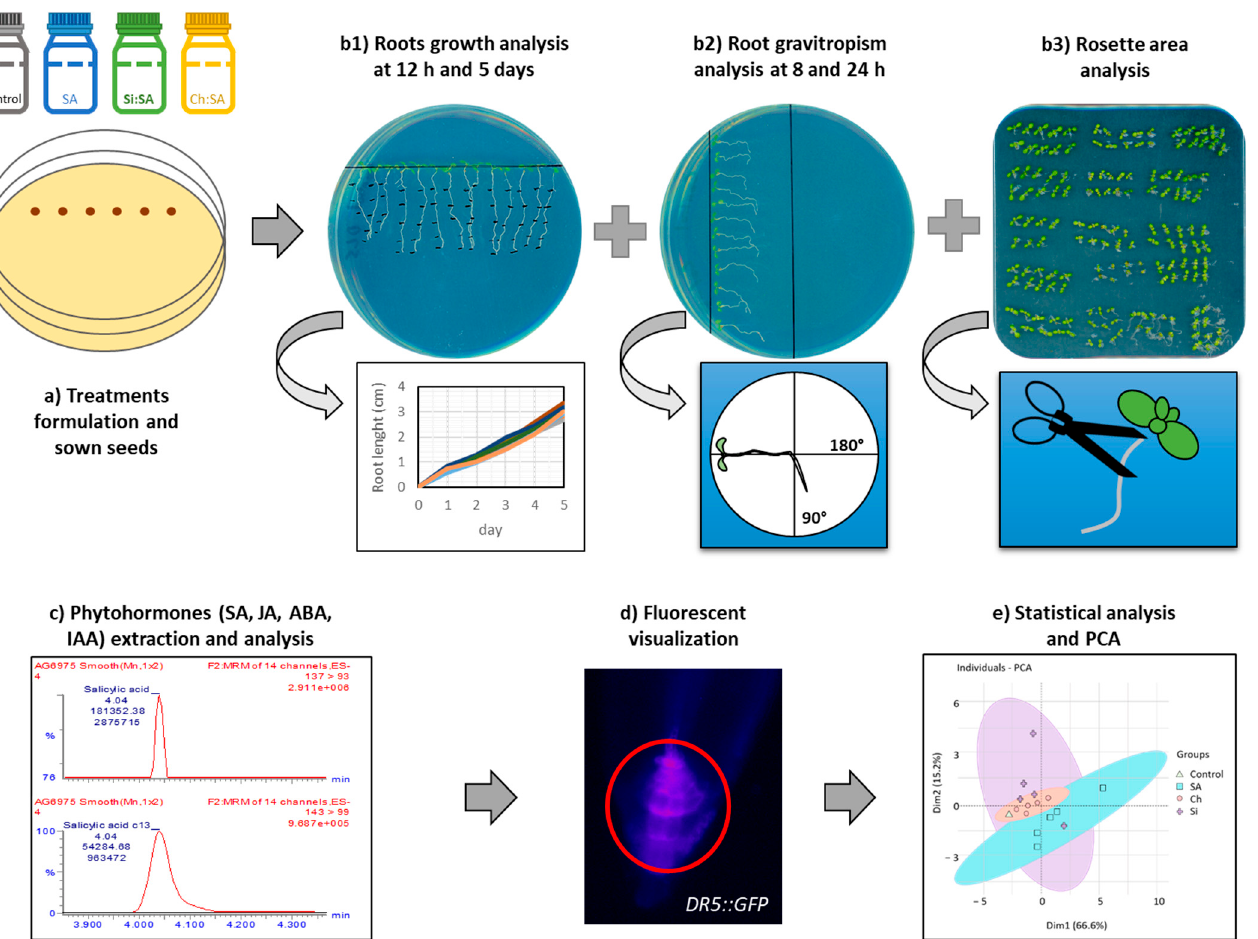
Figure 1. Experimental method developed to determine the effect of free and encapsulated SA (Si:SA and Ch:SA) in Arabidopsis thaliana plants.